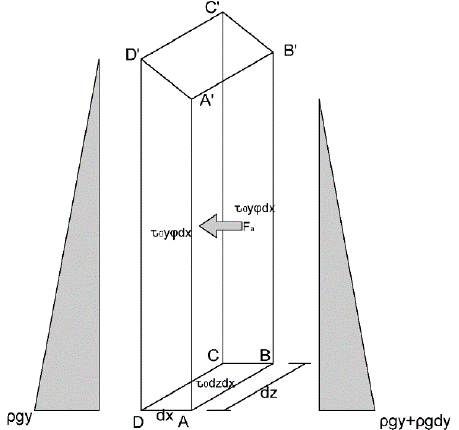
Figure 5. Self-compacting concrete (SCC) distribution in the porous box at the flow stoppage.